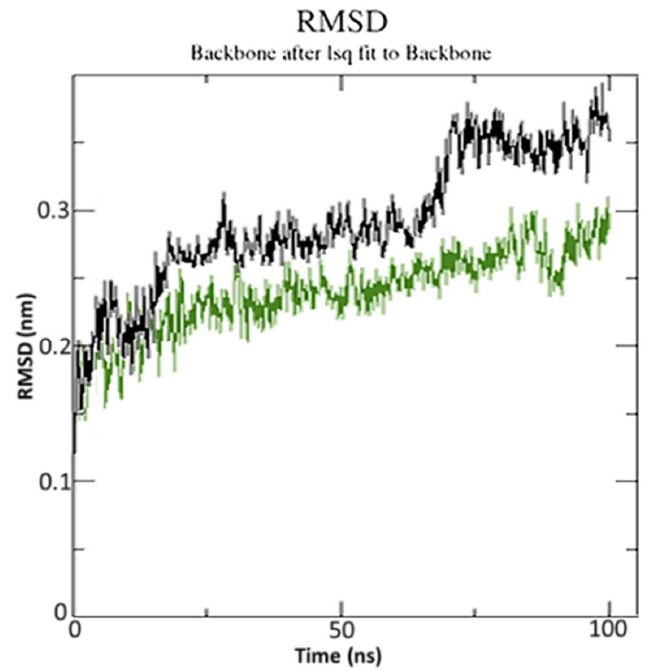
Figure 11. The root mean square deviation (RMSD) of solvated receptor backbone and ligand complex during 100 ns MD simulation [SRXD complex (black) and CTcD complex (green)].